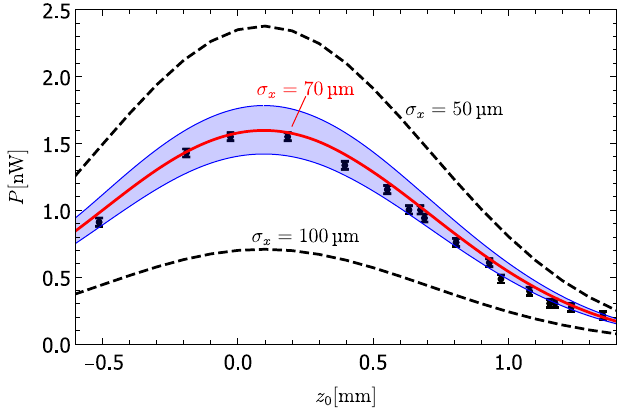
gratings.FIG. 11. SPRpower P vs. distancebetween beam and grating z 0 . Red curve: Calculated behavior [Eq. (2)] with corresponding error ¼ ð 270 (cid:3) 10 Þ fC, σ ¼ σ ¼ ð 866 (cid:3) 15 Þ μ m and a (blue) for Q z y b bunch length of σ x ¼ ð 70 (cid:3) 5 Þ μ m. The dotted lines indicate the calculated behavior for σ x ¼ 50 μ m and σ x ¼ 100 μ m.